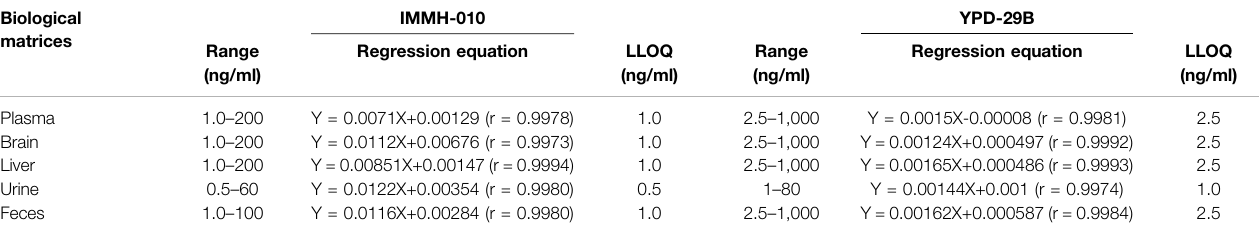
TABLE 1 | The regression equations and LLOQs of IMMH-010 and YPD-29B in biological matrices. Biological